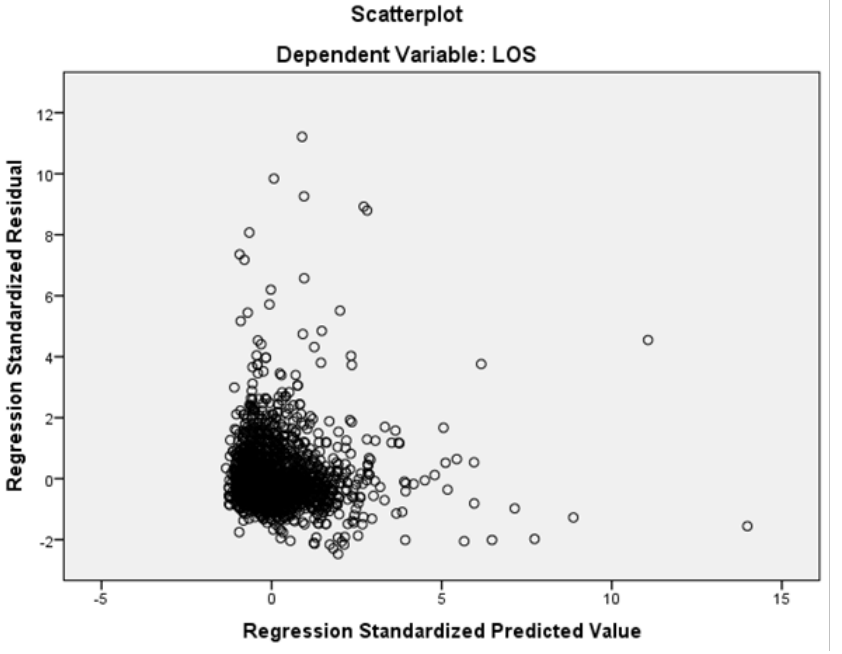
Figure 2. Homoscedasticity of the data.